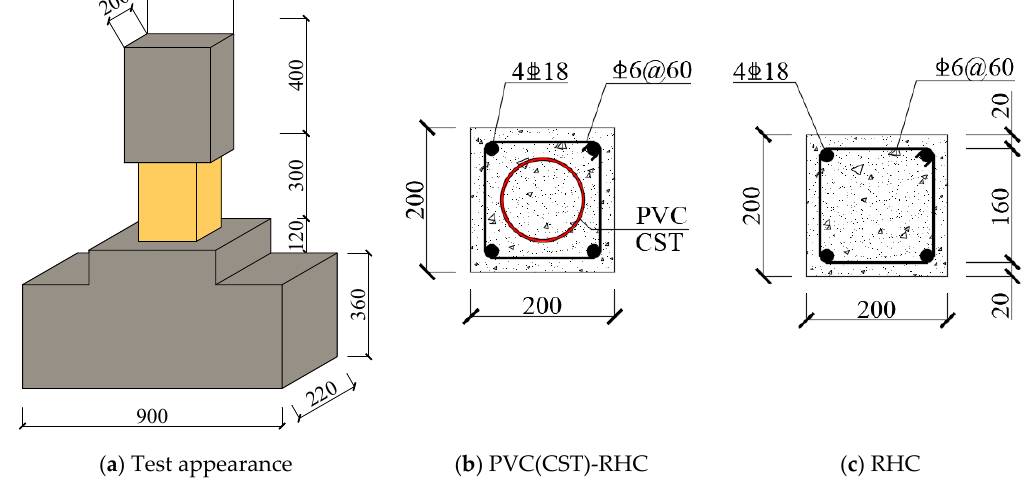
Figure 1. Cross-section dimension and reinforced distribution. PVC, polyvinyl chloride; CST, circle steel tube; RHC, reinforced high-strength concrete.